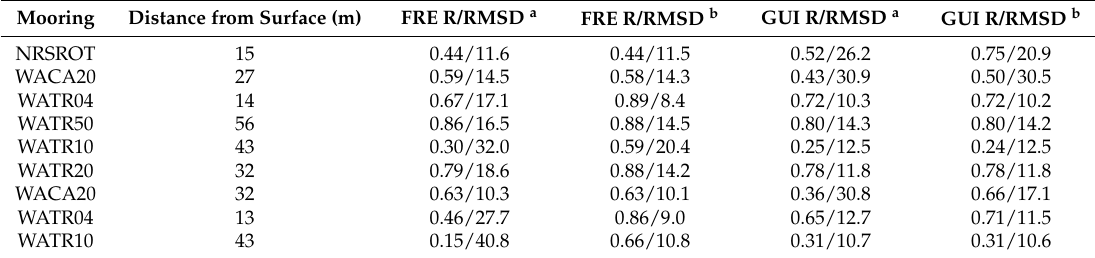
Table 3. Effects of SNR thresholds on radar data: a no threshold applied; b threshold applied. Mooring